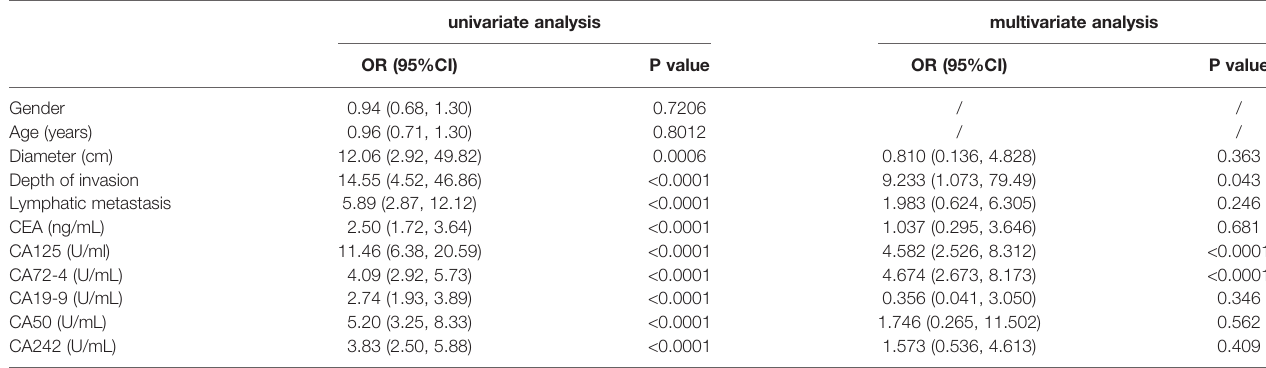
TABLE 2 | Logistic regression analysis of the risk factors for peritoneal dissemination.